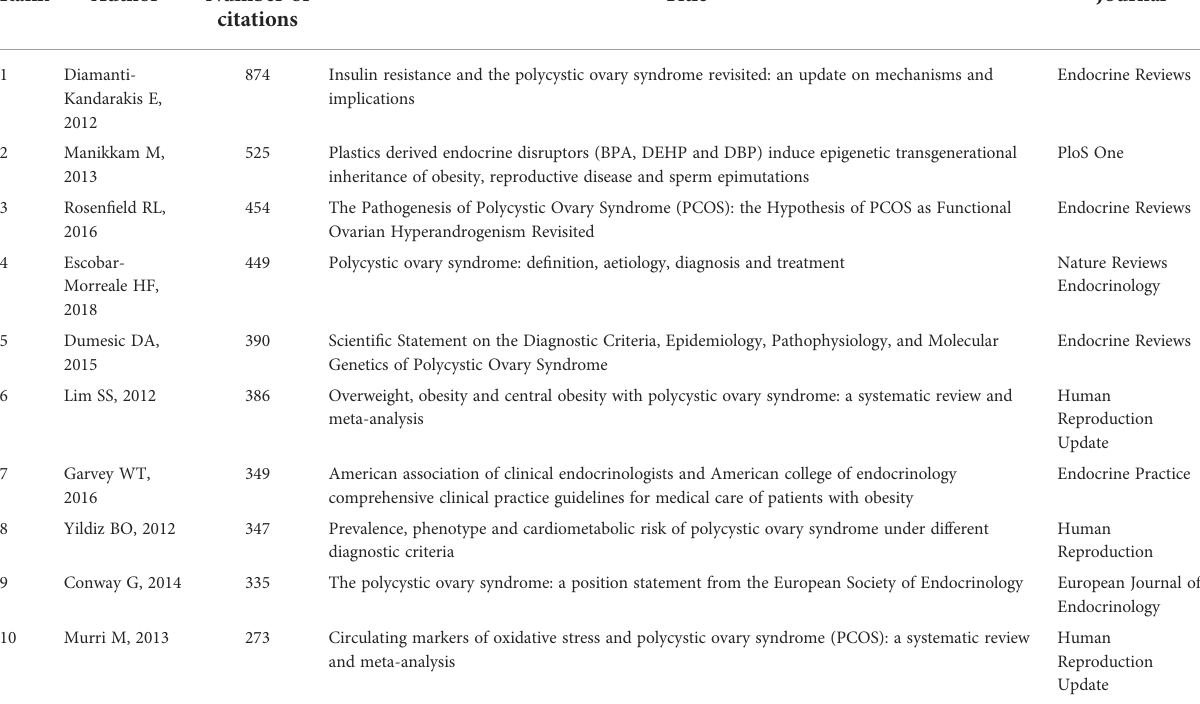
TABLE 3 Analysis of top 10